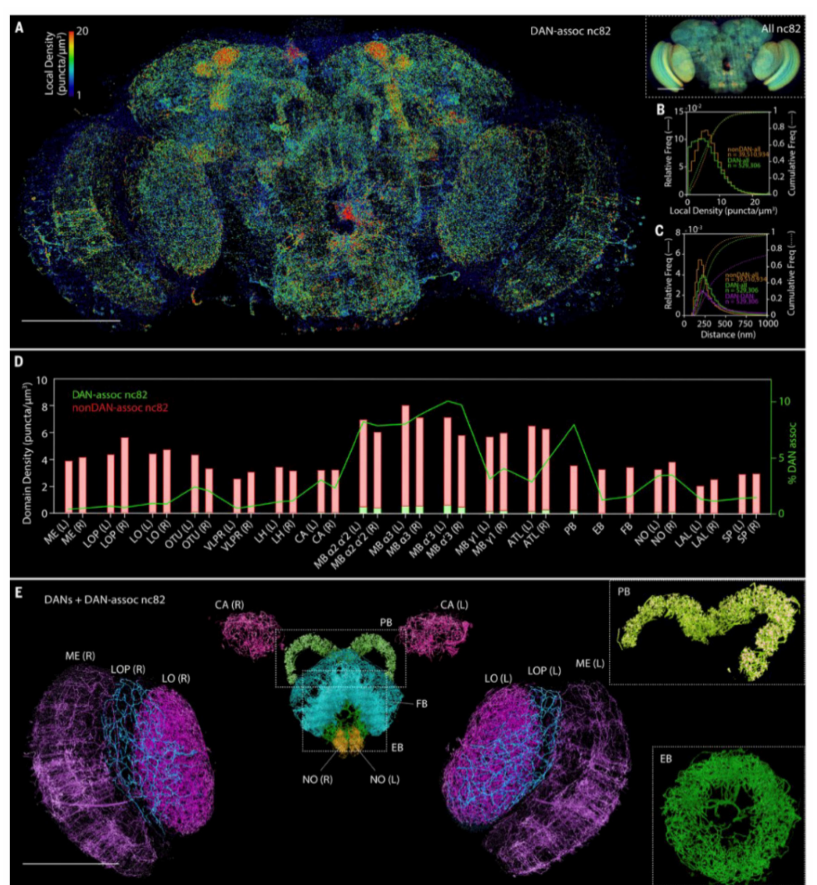
Figure 7. Whole-brain analysis of presynaptic sites and DANs in Drosophila . ( A ) MIP view of the subset of nc82 puncta marking presynaptic sites that are associated with DANs (DAN-assoc nc82), color coded by the local puncta density, in an adult Drosophila brain. Scale bar, 100 µ m. (Inset, right) MIP view of all nc82 puncta, using identical color coding of local density. Scale bar, 100 µ m. ( B ) Distribution of local densities of (green) DAN-associated nc82 puncta and (orange) nonDAN- associated nc82 puncta in ( A ). ( C ) Distribution of distances from DAN-associated nc82 puncta (green) and nonDAN-associated nc82 puncta (orange) to the nearest nc82 punctum of any kind, and nearest- neighbor distances from one DAN-associated nc82 to another (magenta). ( D ) Volumetric density of DAN-associated nc82 puncta (green bars) and nonDAN-associated nc82 puncta (red bars), and the percentage of nc82 puncta that are DAN associated (green curve), within each of the 33 brain regions of the adult Drosophila brain. ( E ) MIP view of DANs and DAN-associated nc82 puncta, color coded by 13 representative brain regions. Scale bar, 100 µ m. (Insets) Magnified views of the (top, angled view) PB and (bottom) EB. Brain regions are ME, medulla; LOP, lobula plate; LO, lobula; OTU, optical tubercle; VLPR, ventrolateral protocerebrum; LH, lateral horn; CA, calyx; MB, mushroom body; ATL, antler; PB, protocerebral bridge; EB, ellipsoid body; FB, fan-shaped body; NO, noduli; LAL, lateral accessory lobe; and SP, superior protocerebrum. “L” and “R” indicate the left and right hemispheres of the brain, respectively. From Gao et al. [11]. Reprinted with permission from